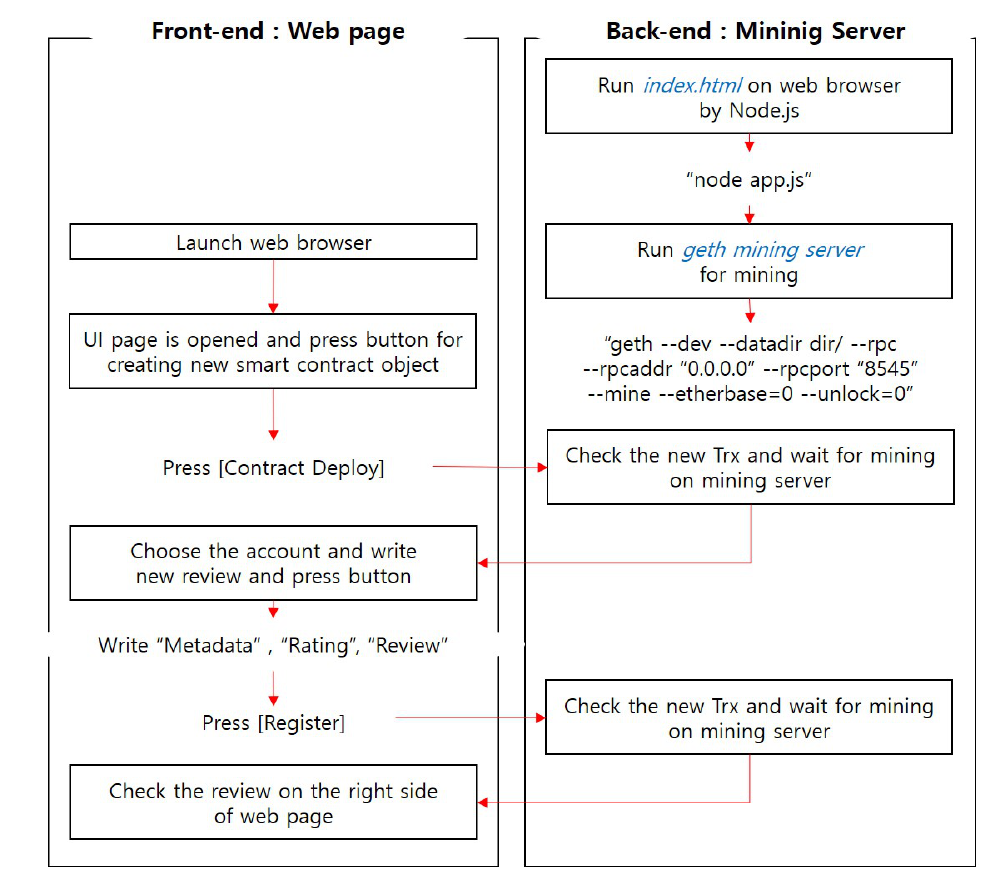
Figure 3. Function process of